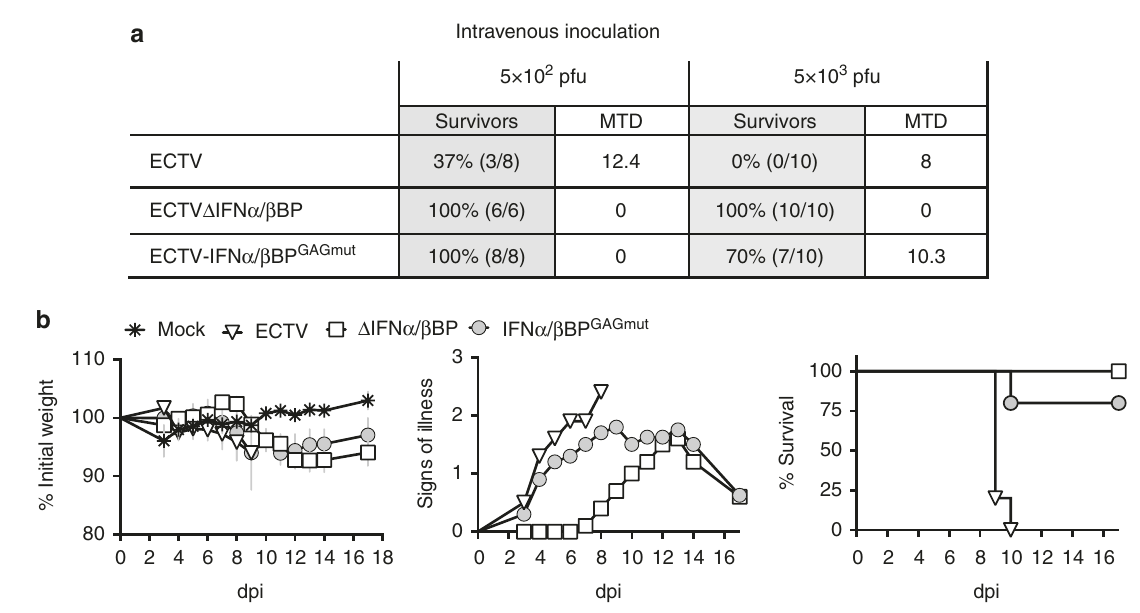
Fig. 7 Infection by i.v. inoculation of ECTV IFN α / β BP mutants. Balb/c mice were i.v. infected with 5 × 10 2 or 5 × 10 3 pfu of the indicated ECTV mutants. a Survival rates and mean time to death (MTD)±SD from three independent experiments are shown. b A representative experiment of two showing weight loss, clinical signs and survival from animals infected with 5 × 10 3 pfu of the ECTV